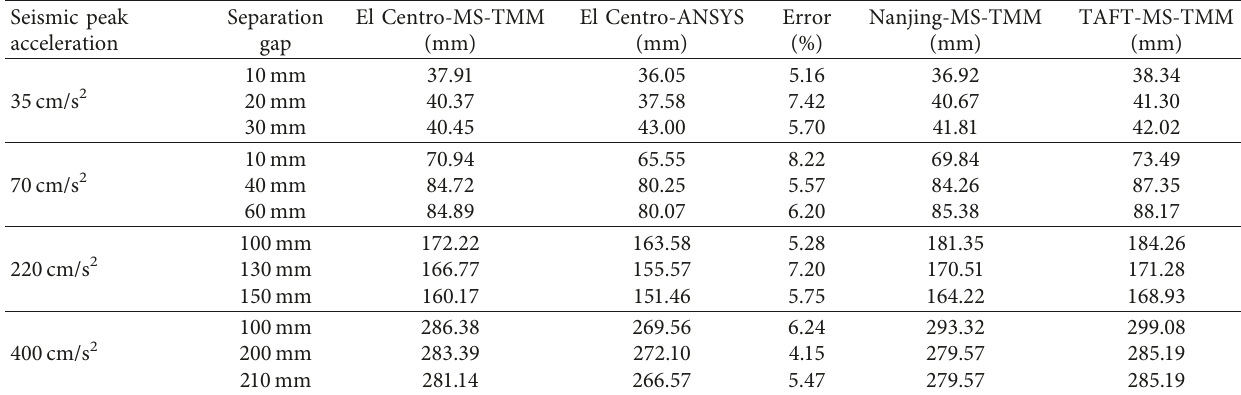
Table 5: Peak displacement of J